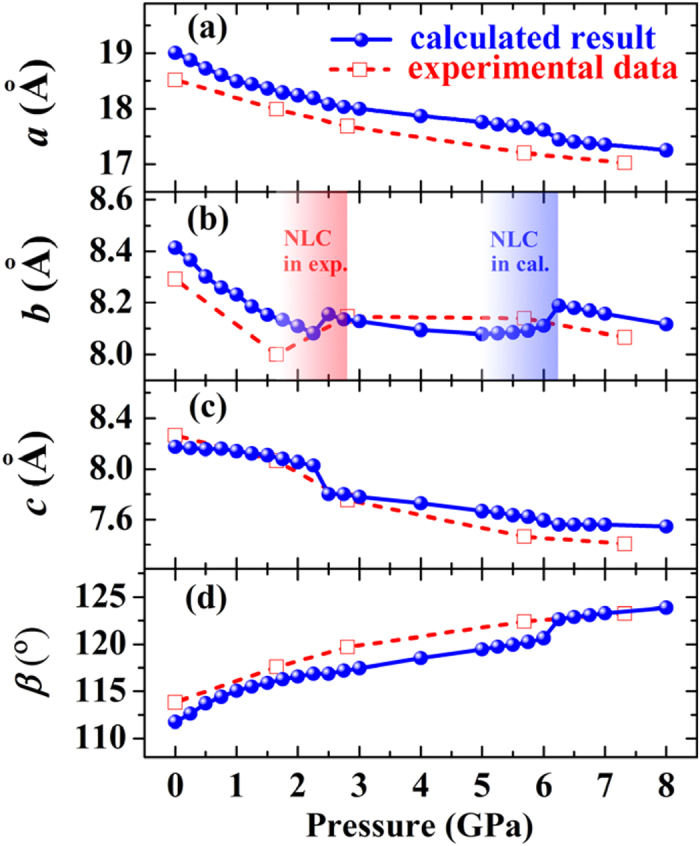
Experimental and calculated lattice parameters.Red and blue shaded areas in (b) manifest the NLC zone in experiment (from 1.65 to 2.81 GPa with increase of 1.8% in b axis) and calculation (from 5 to 6.25 GPa with the increment of 1.4% in b axis), respectively.